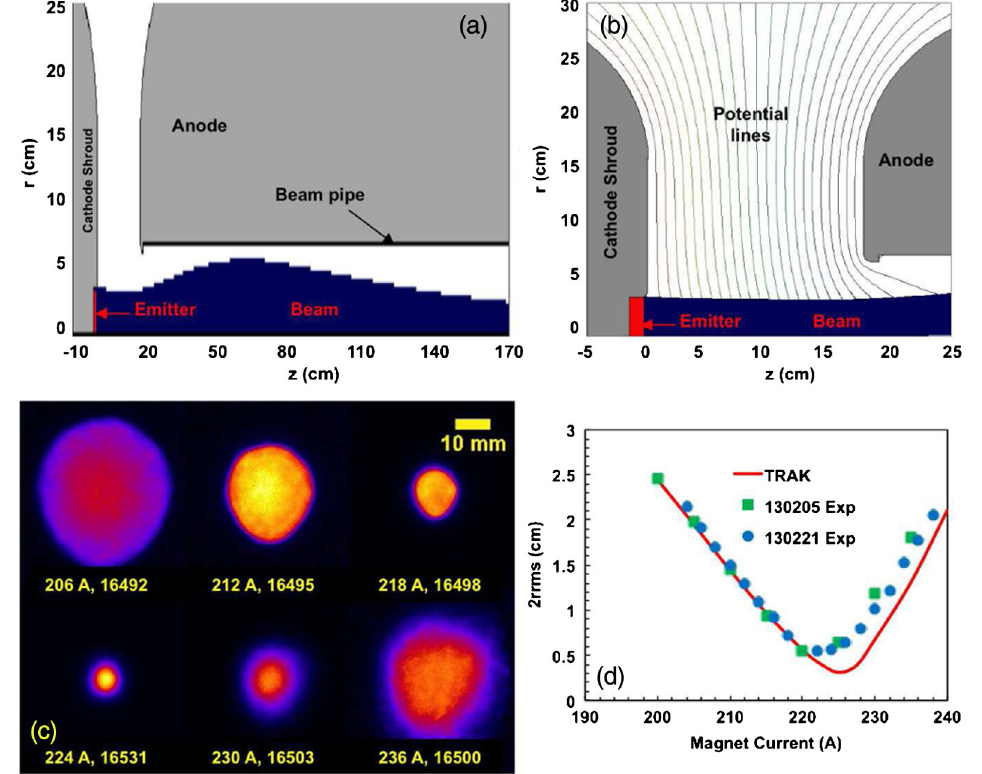
FIG. 3. (a) The transported beam envelope to the diagnostic location at z ¼ 167 cm calculated in TRAK with the first transport magnet current set to 200 A; (b) the extracted beam envelope through the diode calculated in TRAK; (c) measured J ð x; y Þ for indicated transport magnet currents and shot number at z ¼ 167 cm; and (d) comparison of the measured 2 rms radius of the beam and that calculated with the TRAK code at z ¼ 167 cm all for the 3.8 MV, 2.9 kA beam.